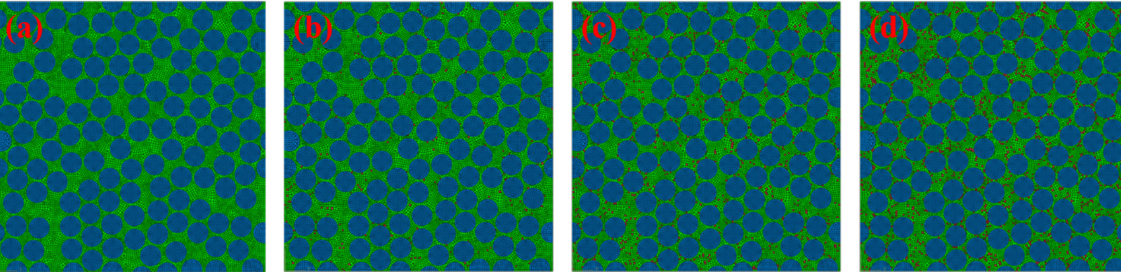
Figure 2. Microscale finite element model of randomly distributed fibers with void contents: ( a ) 0%, ( b ) 1%, ( c ) 3% and ( d ) 5%.